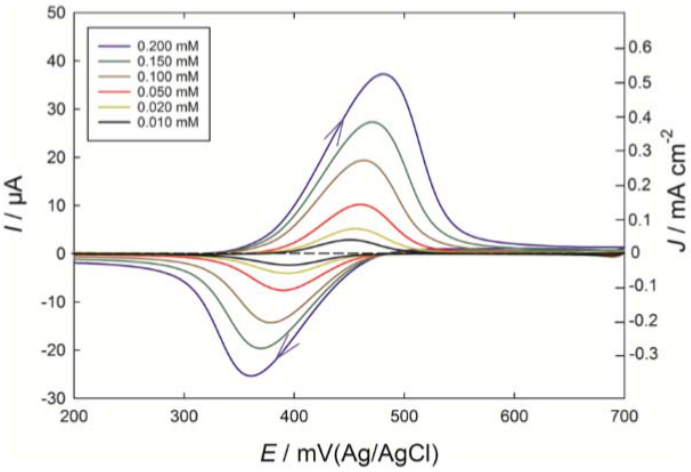
Figure 6. Cyclic voltammograms at a PEDOT electrode of phenolic standards in the concentration range from 0.01 to 0.20 mM, dissolved in the pH 3.6 model wine solution: (a) CA taken to 700 mV.